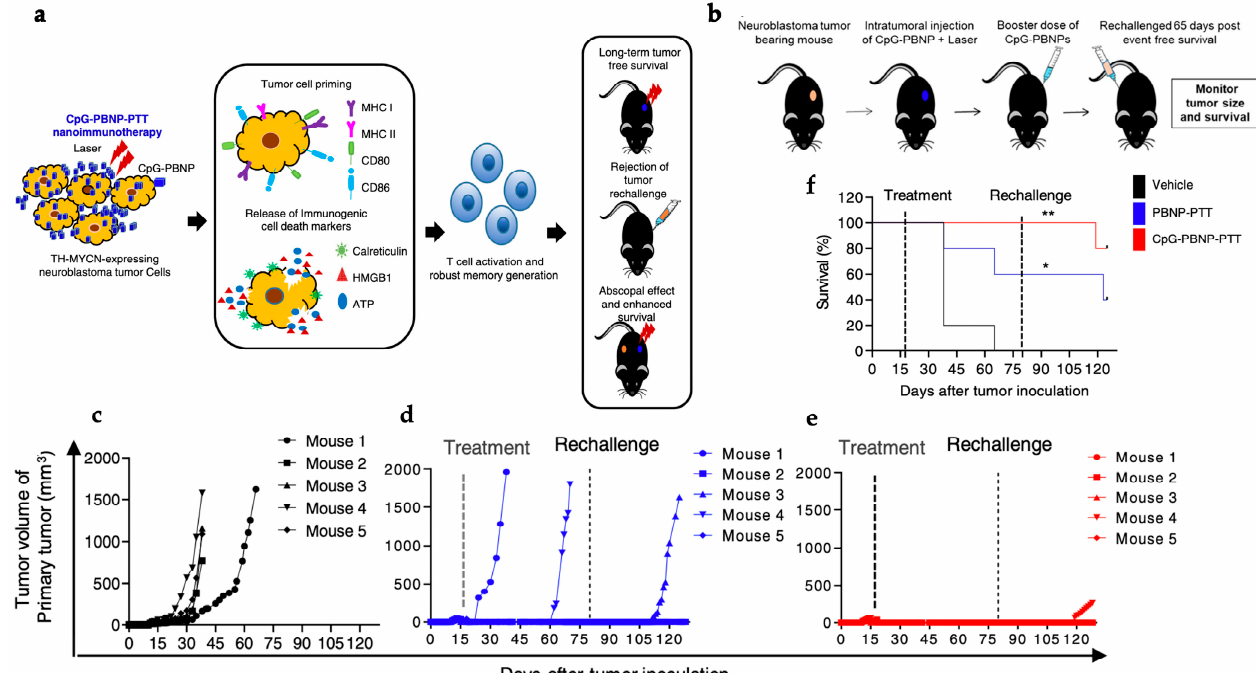
Figure 8. PBNPs synergetic PTT-immunotherapy strategy. ( a ) CpG-PBNPs photo-immunotherapy of MYCN overexpressing neuroblastoma cells enhances the antigen presentation by tumor cells as well as ICD triggering, promoting T cell activation and long term antitumoral memory effects. Treatment may promote long term tumor free survival, suppresses tumor rechallenging and elicits abscopal effects. ( b ) 9464D model cells were subcutaneously injected in mice and grown to a diameter of at least 5 mm. Tumor-bearing mice were divided into 3 treatment groups ( n = 5): Vehicle (PBS), PBNP-PTT treatment and CpG-PBNPs-PTT treatment. Laser irradiation (808 nm, 1.5 W/cm 2 , 10 min) to a temperature of 120 ◦ C. CpG-PBNP boosts without irradiation were injected on days 2 and 5. After 65 day of tumor free survival, the remaining mice were rechallenged to evaluate long term antitumor memory. ( c – e ) Tumor growth curves of tumor bearing mice treated with PBS ( c ), PBNP-PTT ( d ) and CpG-PBNP-PTT ( e ). ( f ) Survival plot of tumor bearing mice after treatment at day 18 with PBS, PBNP-PTT and CpG-PBNP-PTT and rechallenging at day 80. Data are means ± SD. * p < 0.05, ** p < 0.01. Adapted with permission from [141] © 2021 Wiley-VCH Gm.bH